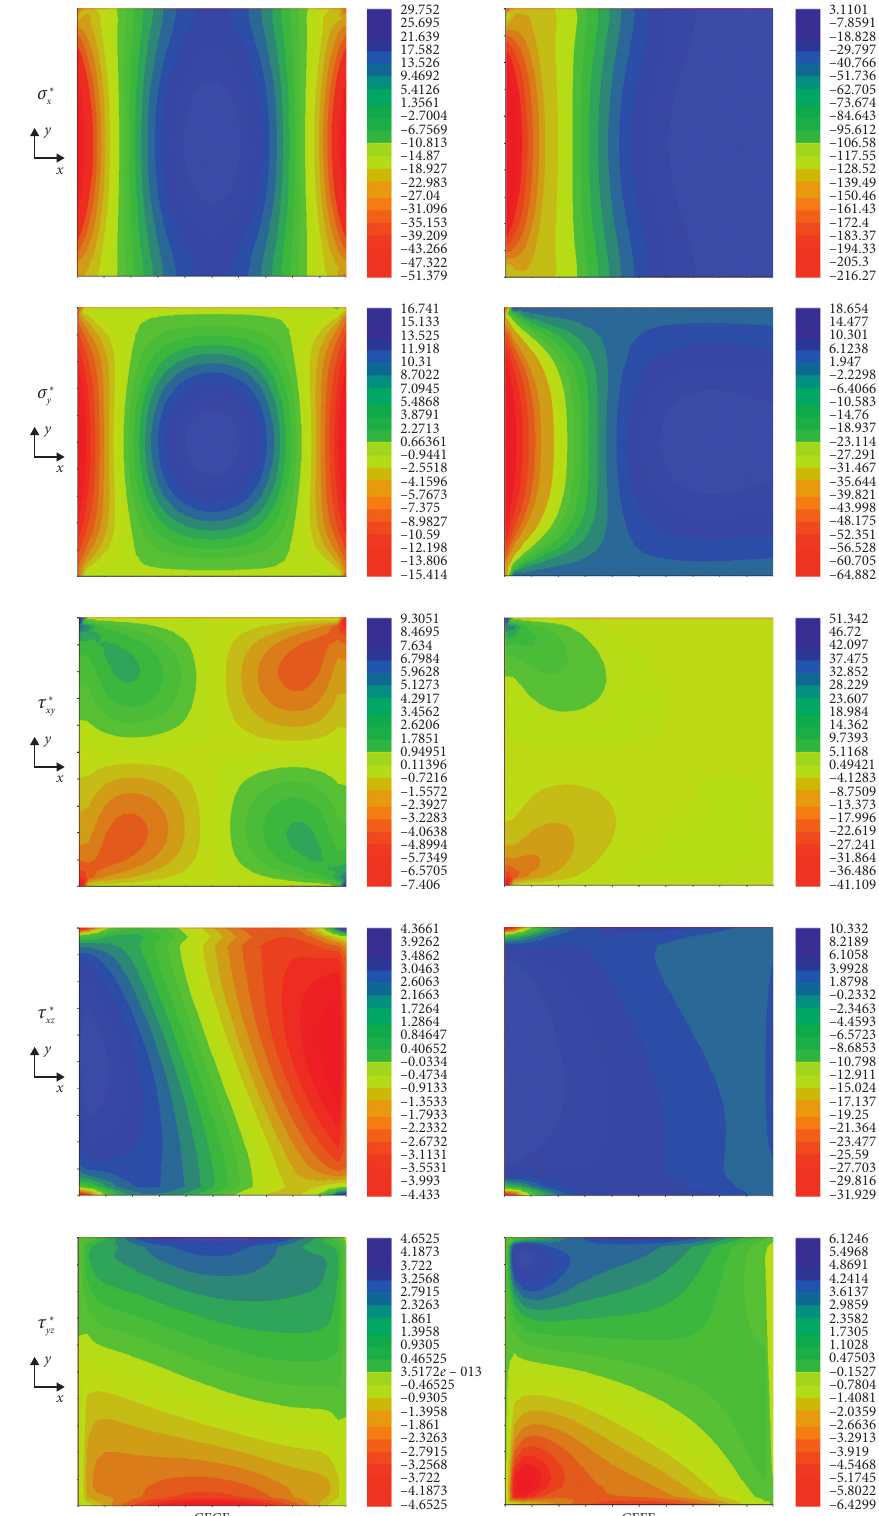
Figure 6: The stress distribution surface ( xy -plane) of FGM nanoplate subjected to sinusoidally distributed load n � 1, a / h � 10, a / b � 1, and ψ �